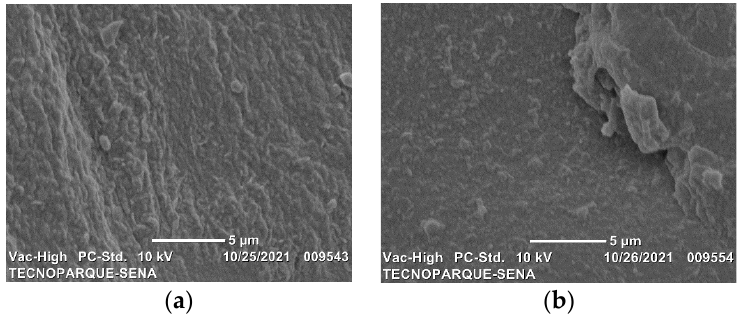
Figure 2. SEM micrographs for achira starch-PVA biodegradable films with MMT nanoclay (0.5, 1.0 and 1.5%), treated with (-s) and without sonication. ( a ) SP, ( b ) SP0.5MMT, ( c ) SP1.0MMT, ( d )